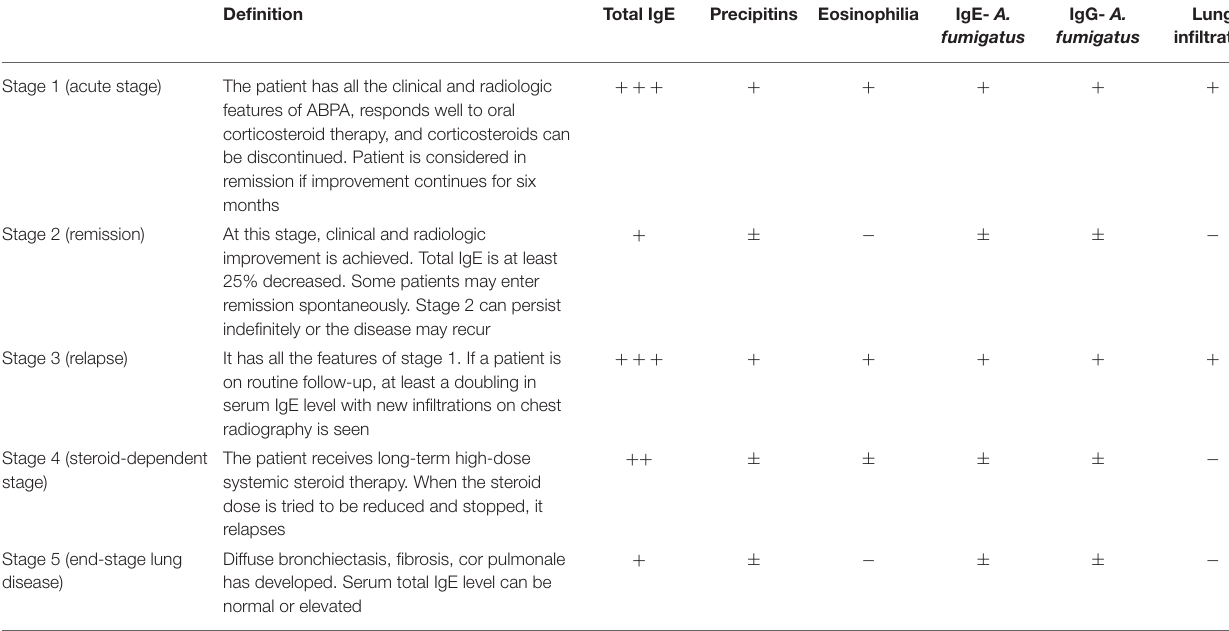
TABLE 1 | Clinical and serological characteristics of ABPA